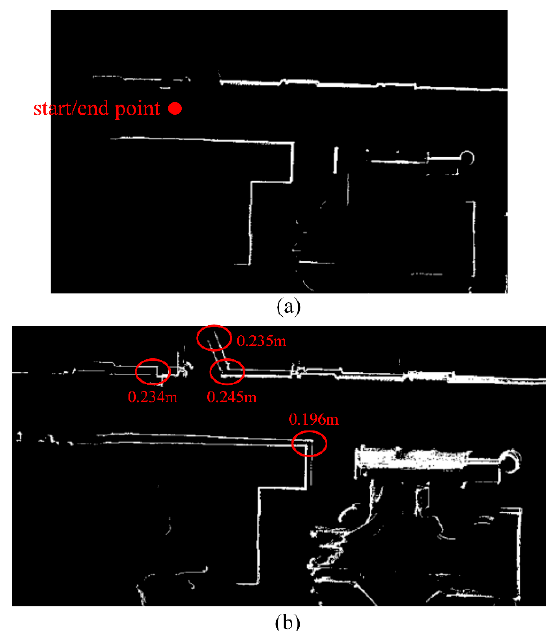
Figure 8. The occupancy likelihood maps near the start/end point, generated by our proposed OWOLM ( a ) and the traditional OLM ( b ) approach. Brighter intensities indicate higher likelihood values. Red numbers represent biases between two contours in the red ellipsoid.